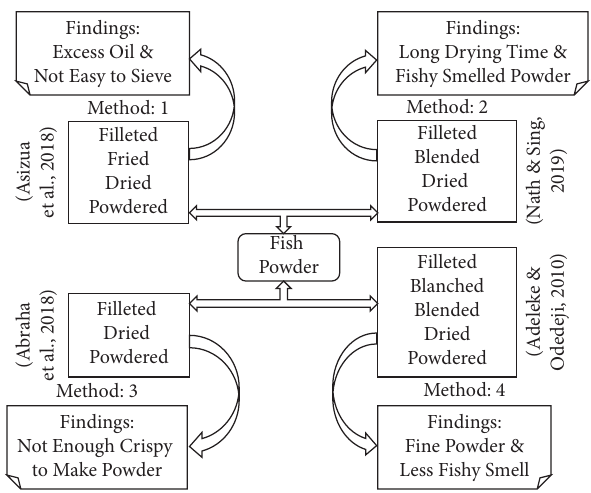
Figure 1: Experimental